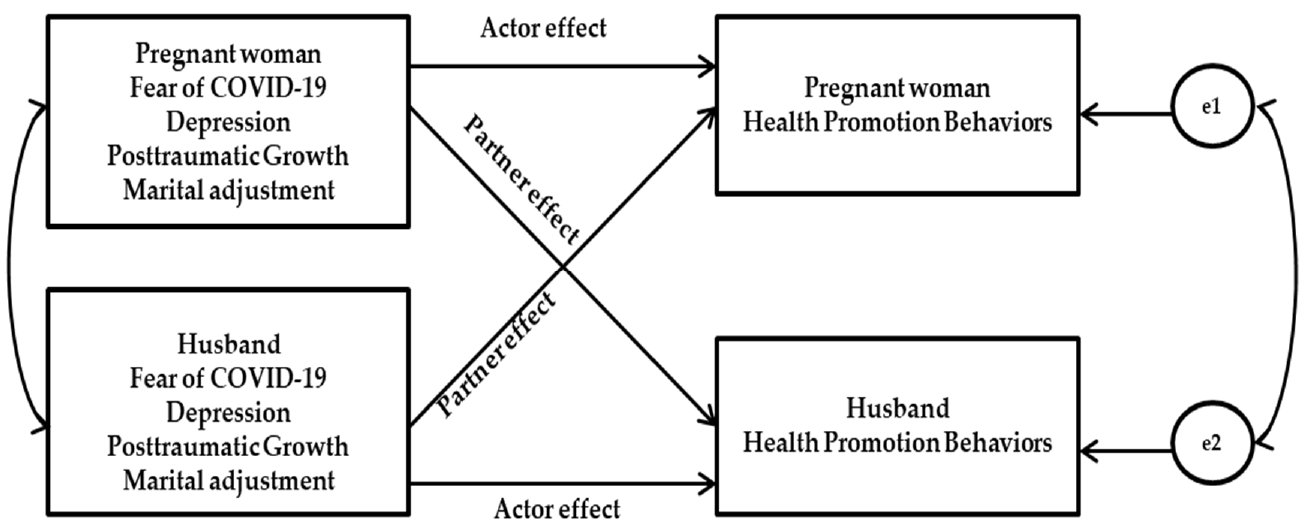
Figure 1. Conceptual framework of the study. Note. e1 and e2: measurement error variance.